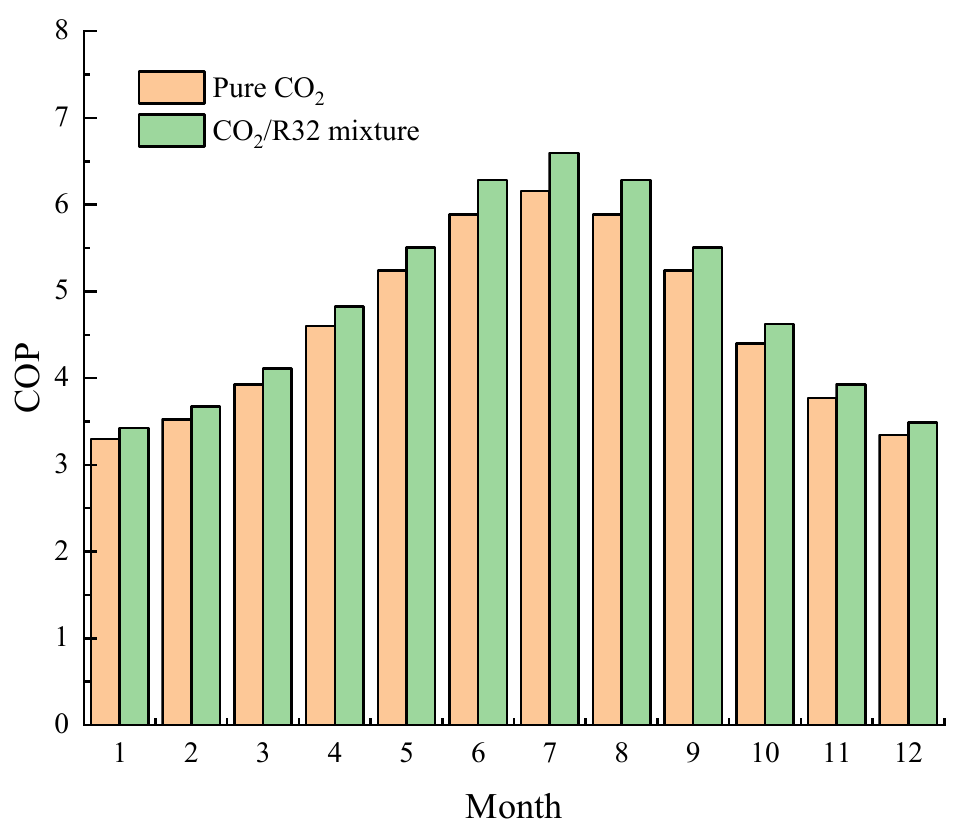
Figure 12. Location and detailed information of Xi’an city.